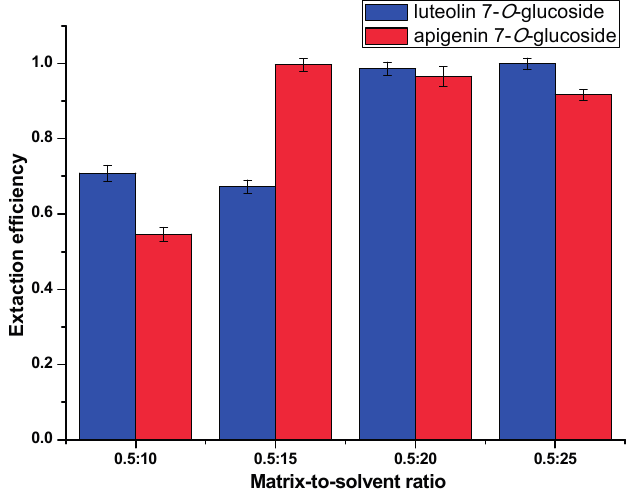
Figure 7. Extraction efficiency at different matrix-to-solvent